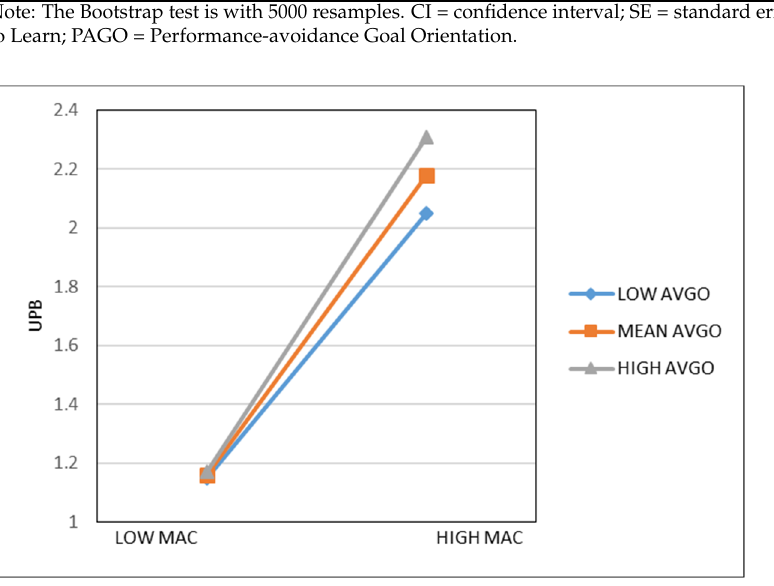
Figure 2. the Moderating role of PAGO on the relationship between MAC and UPB. Note: UPB = Unethical Pro-organizational Behavior; MAC = Machiavellianism; PAGO = Performance-avoidance Goal Orientation.